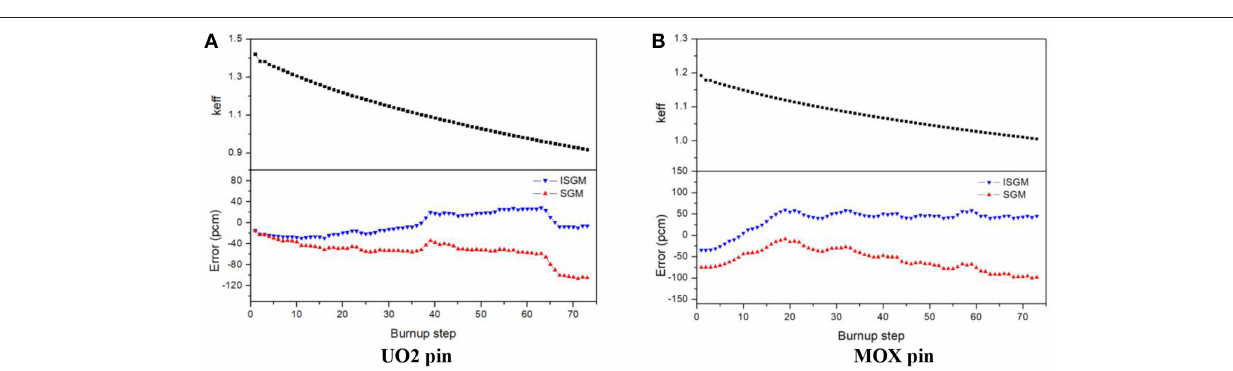
FIGURE 8 | Eigenvalue of single call in each burnup step. (A) UO2 pin, (B) MOX pin.